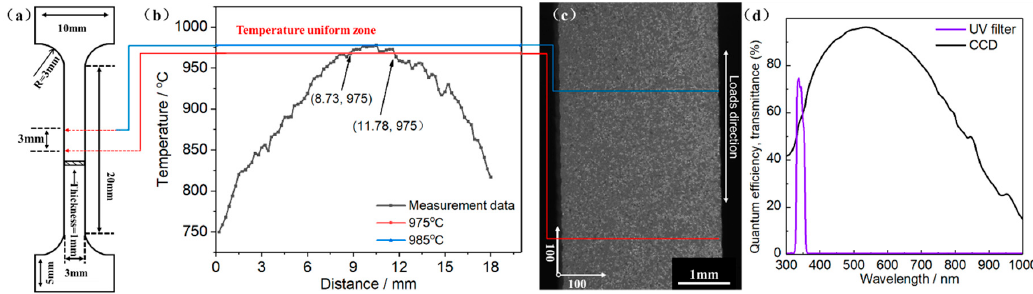
Figure 2. ( a ) The thin-wall (TW) specimen with [001] orientation; ( b ) the measurement for temperature uniform zone; ( c ) TW specimen for [001]-creep test with (010) observed speckled surface, the area between red and blue line are the temperature uniform zone; ( d ) the quantum efficiency of the charge-coupled device (CCD) and the transmittance of bandpass filter was used.